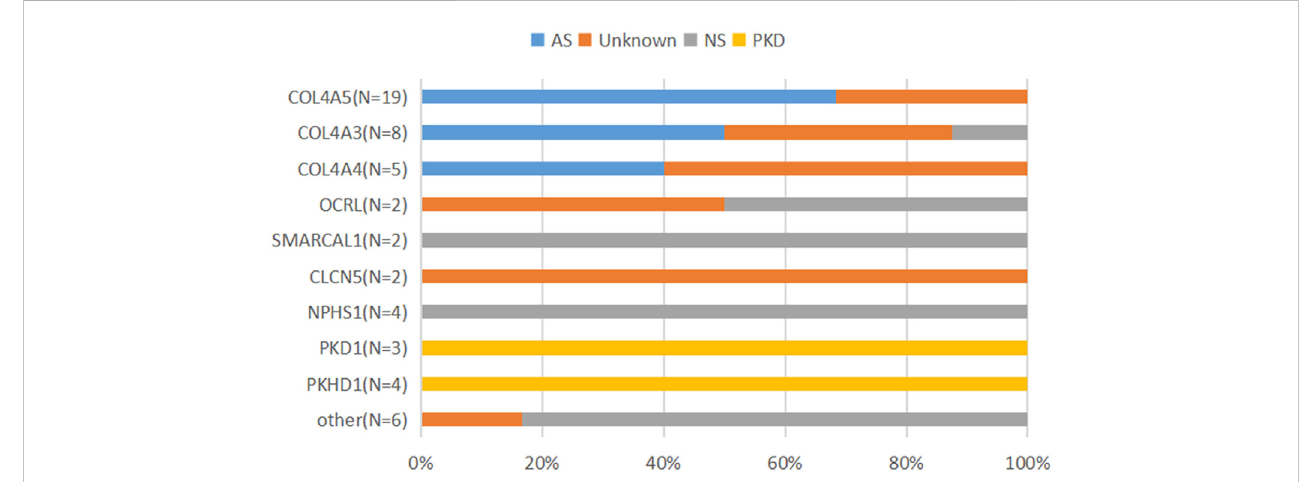
FIGURE 2 Clinical diagnostic spectrum of patients with genetic diagnosis of IKDs. The patients who were clinically diagnosed with NS were associated with CLO4A3 , OCRL , SMARCAL1 , and NPHS1 or other genes; the patients who were clinically diagnosed with AS were associated with COL4A3 , COL4A4 , and COL4A5 ; the patients clinically undiagnosed (unknown) were associated with the genes of COL4A5 , COL4A3 , COL4A4 , OCRL , and CLCN5 and